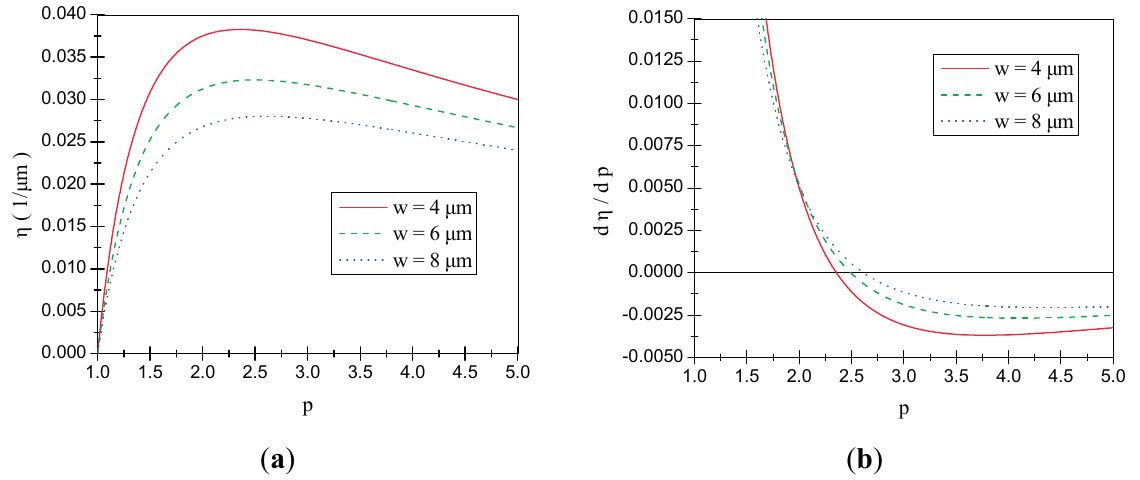
Figure 5. ( a ) Change tendency of η with the variation of p; ( b ) Change tendency of d η /dp with the variation of